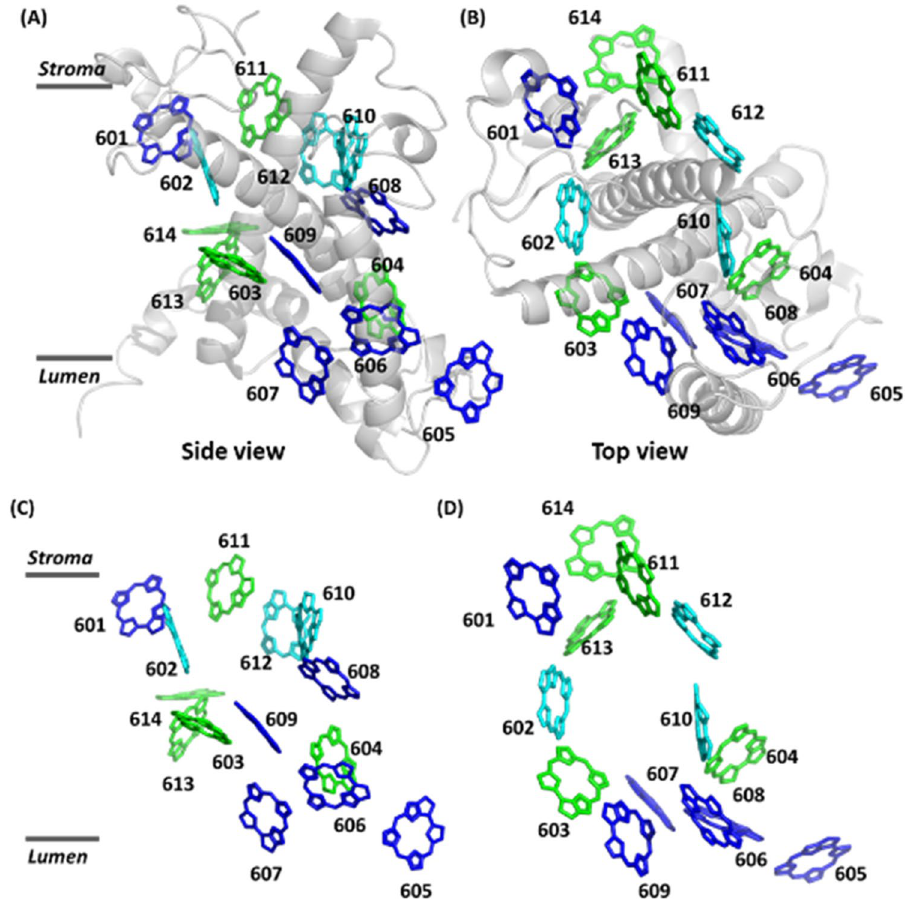
Figure 1. High-resolution structure of a monomer of LHC II from spinach [PDB:1RWT]. ( A, C ) Side view of the arrangement of the Chl molecules with ( A ) and without ( C ) the protein backbone. ( B, D ) Top view of the arrangement of the Chl molecules with ( B ) and without ( D ) the protein backbone. Chl a molecules are shown in green, Chl b molecules are show in blue. For clarity the carotenoids have been omitted. For SCP the Chl a molecules in position 602, and either those in positions 610 or 612 are exchanged to Chl b as indicated by the cyan colour. The Chl molecules are numbered according to the scheme given in 9 (1RWT). The figure has been produced using PyMOL ver.